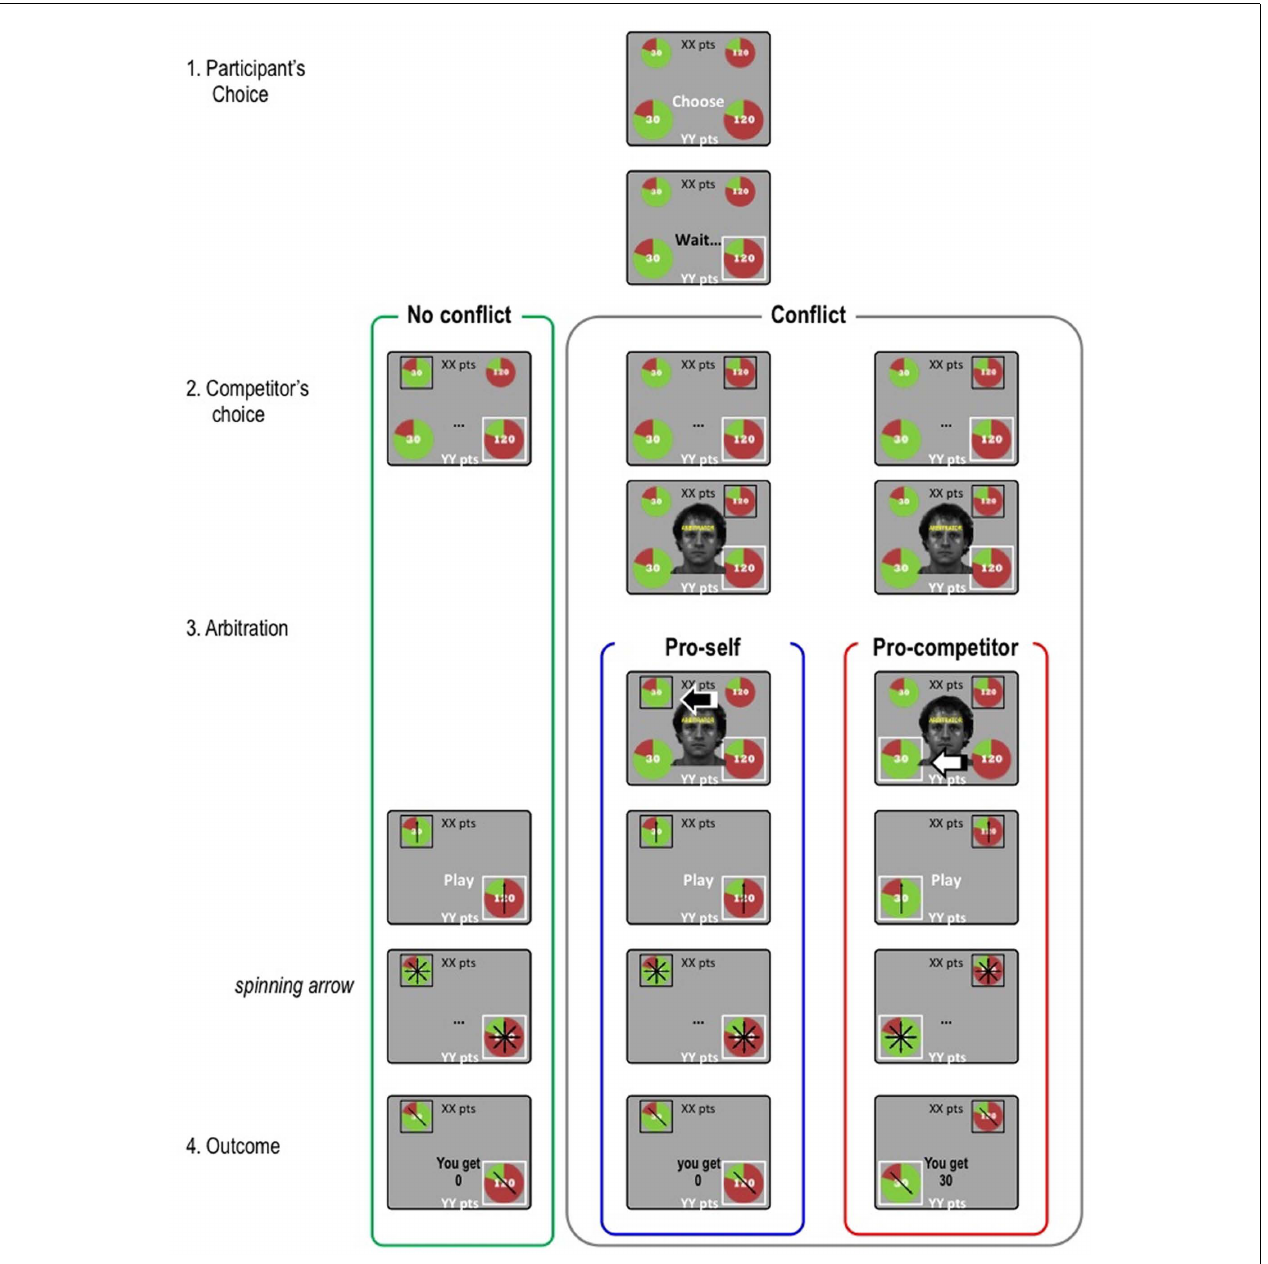
FIGURE 1 | Description of the task: trial events for the three different arbitration conditions (no-conflict, pro-self awards, and pro-competitor awards).